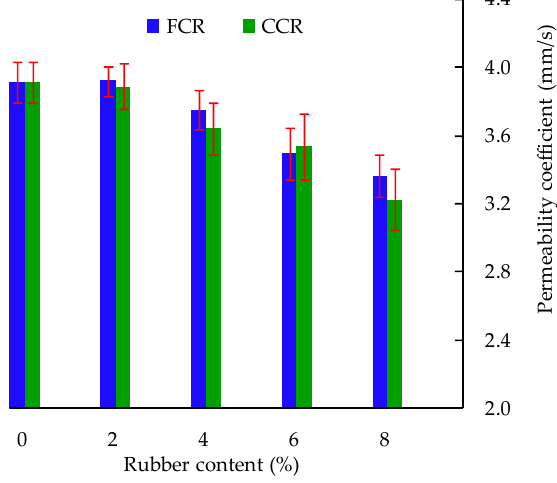
Figure 5. Permeability coefficient of RMPC versus rubber content.